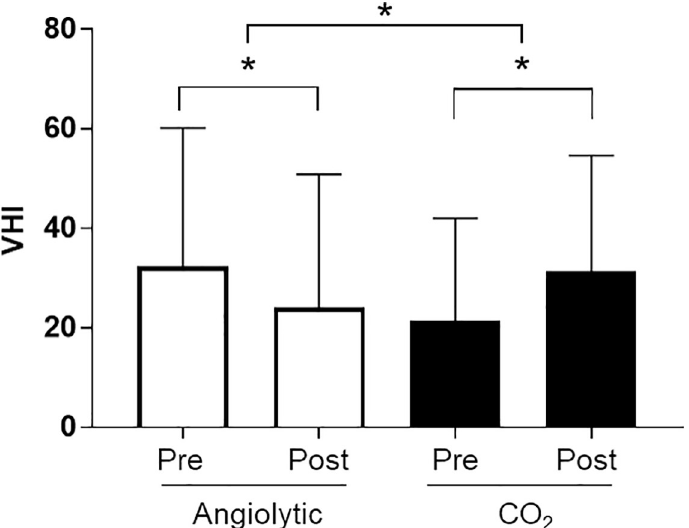
Fig 3. Voice Handicap Index scores before and after the